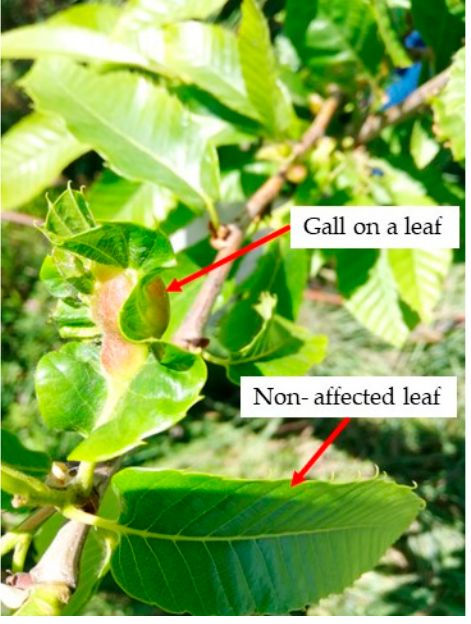
Figure 8. Chestnut wasp gall a ff ected leaf and healthy leaf on the same branch.